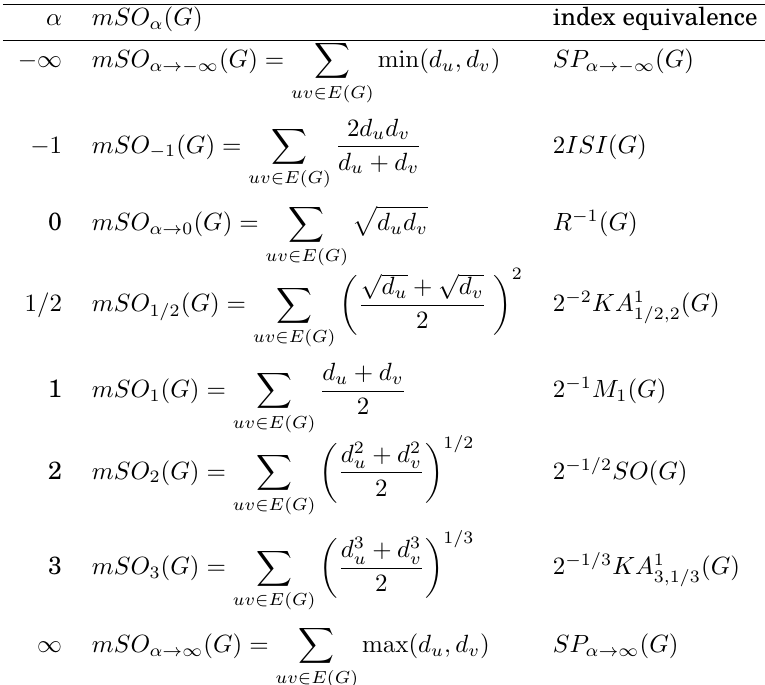
for selected values of α α ( G )